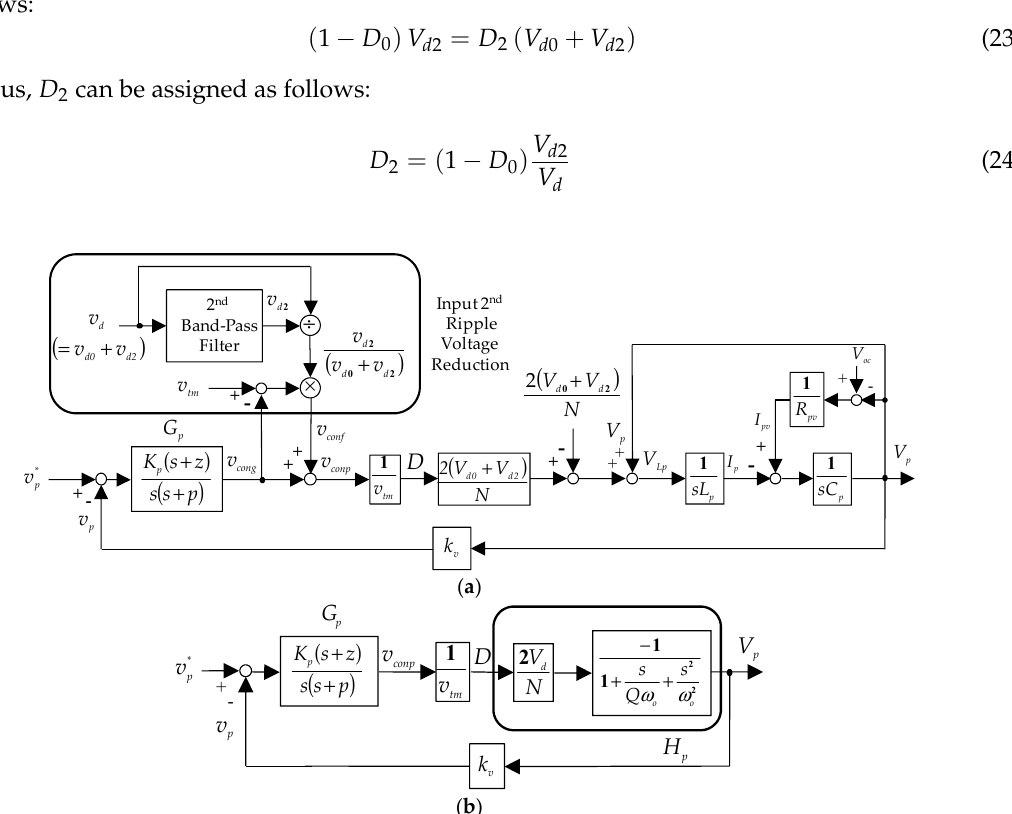
Figure 6. PV voltage control loop design: ( a ) control block diagram; ( b ) small signal control block diagram.